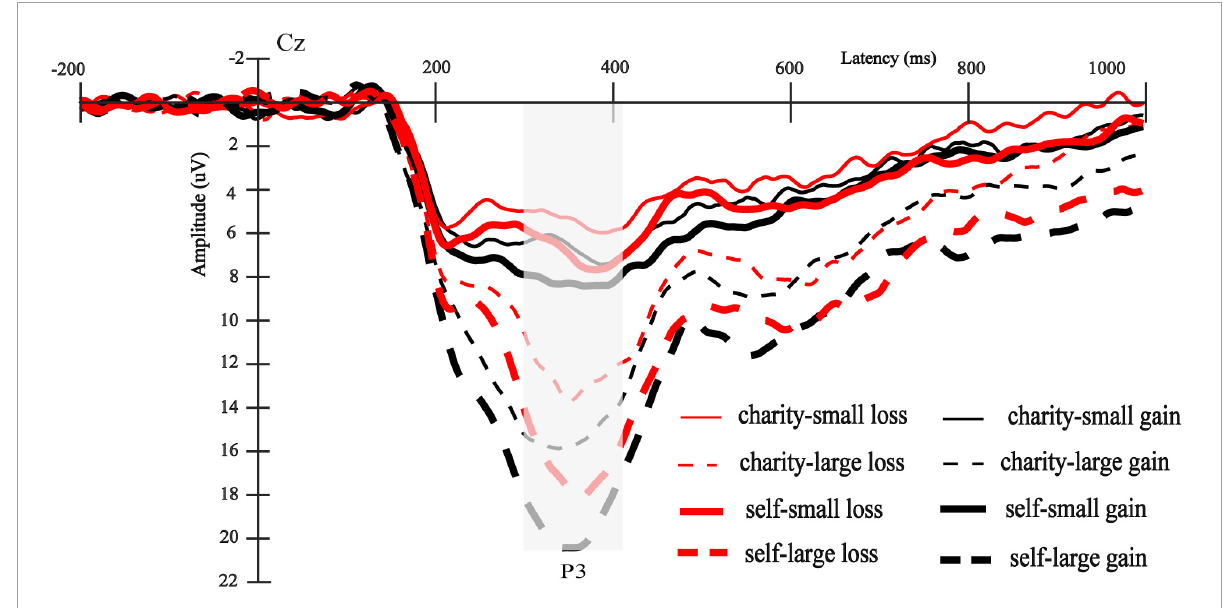
FIGURE6 The total average P3 waveforms for all conditions.